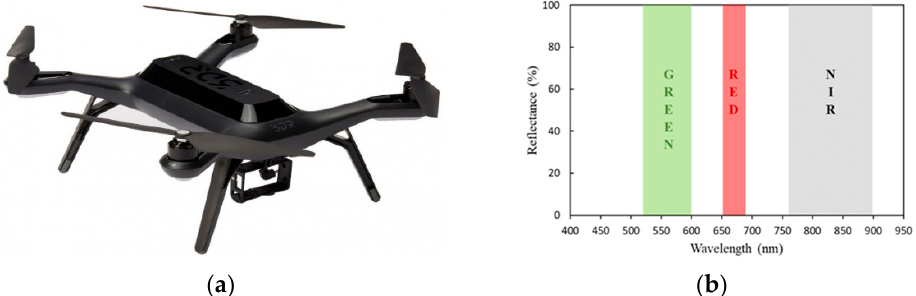
Figure 1. Photograph of ( a ) the 3DR Solo quadcopter drone and ( b ) spectral ranges of the three multispectral sensors in the agricultural digital camera used in the study.